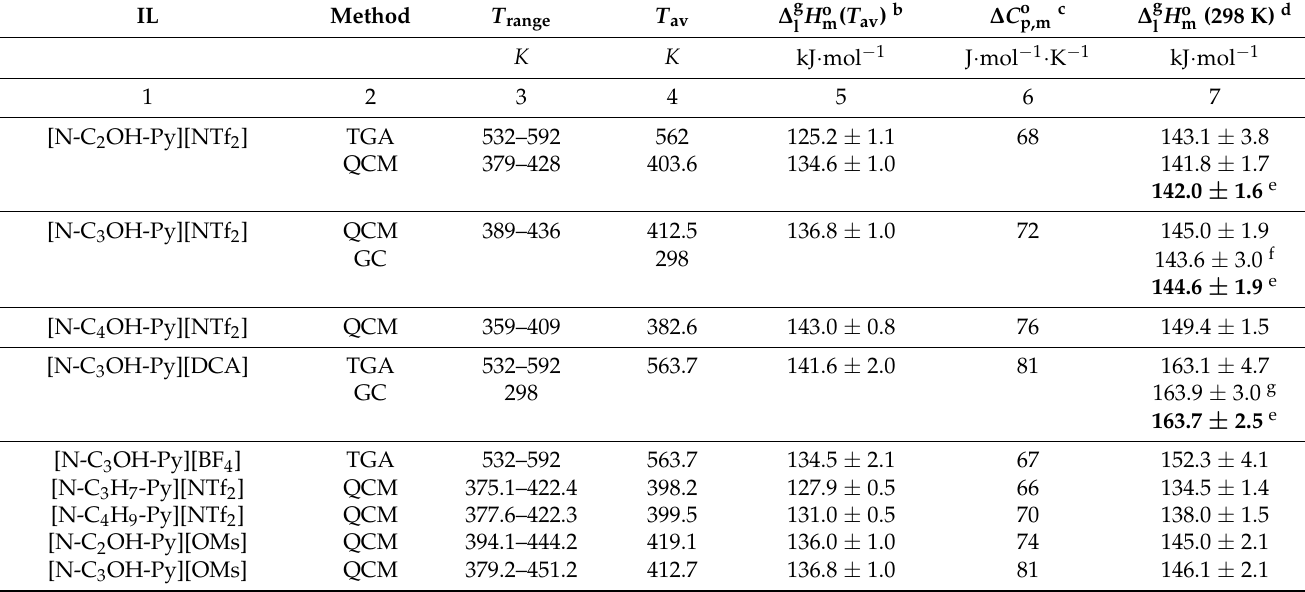
Table 4. Experimental vaporisation enthalpies of pyridinium-based ionic liquids a